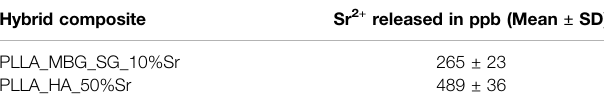
TABLE 3 | Sr 2+ ion released from the composite fi laments after 7 days of